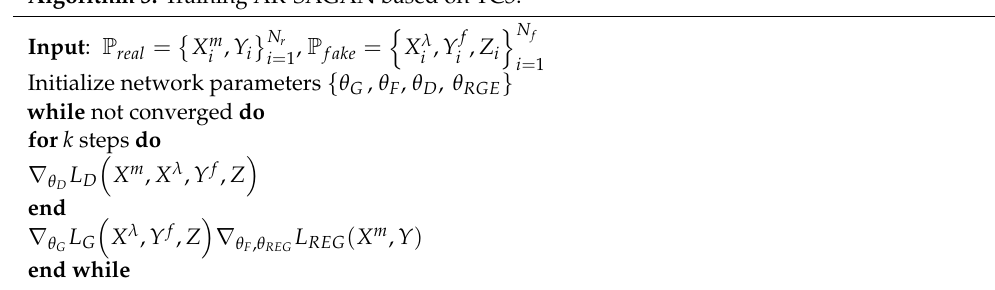
Algorithm 3: Training AR-SAGAN based on